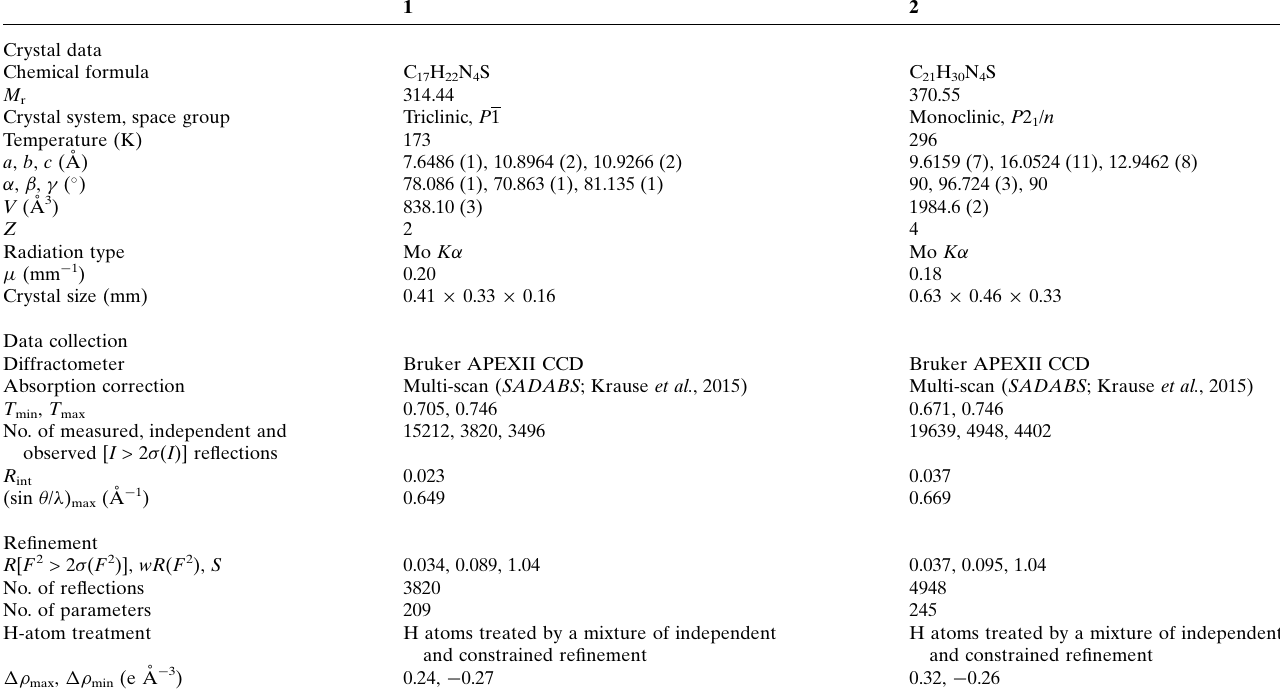
Table 3 Experimental